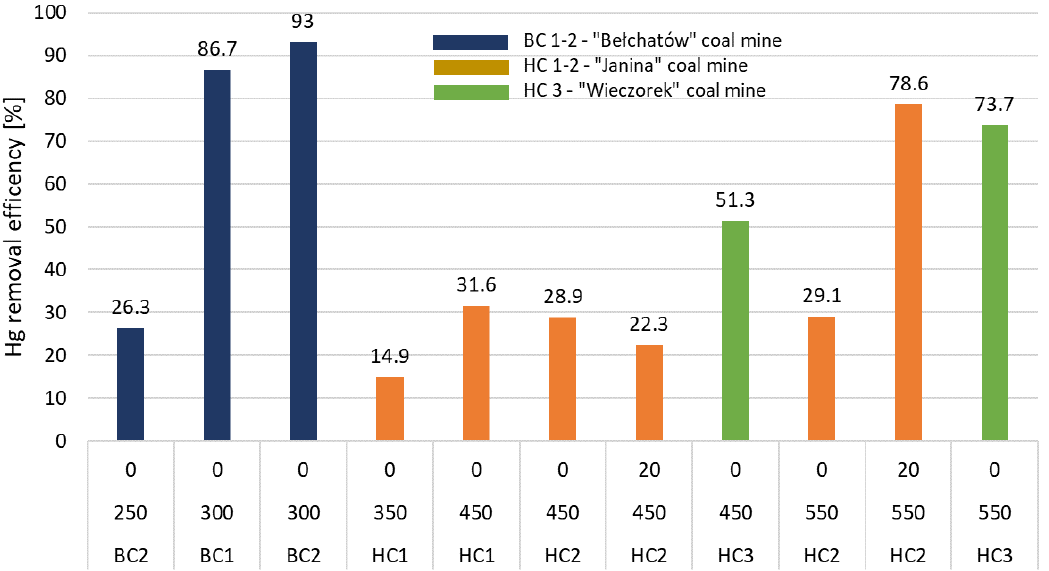
Figure 6. Hg removal efficiency of bench scale experimental test, %. Results obtained for lignite (BC1, BC2) confirmed high Hg removal efficiency. When